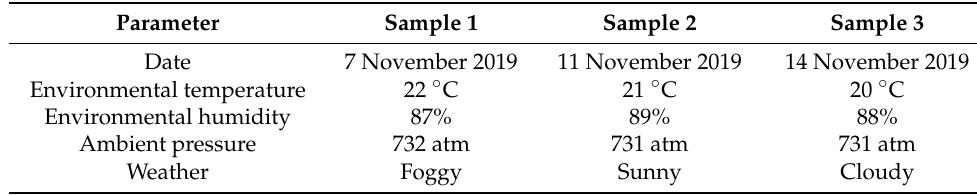
Figure 1. Sampling location. ( A ) Huitzilac, Morelos (red star). ( B ) Maguey cultivation zone. ( C ) One of the three plants sampled for aguamiel and metzal. ( D ) Cajete or cavity where aguamiel accumulates after scraping the walls, ( E ) Sample of the scraped metzal tissue. Table 1. Sample collection characteristics.